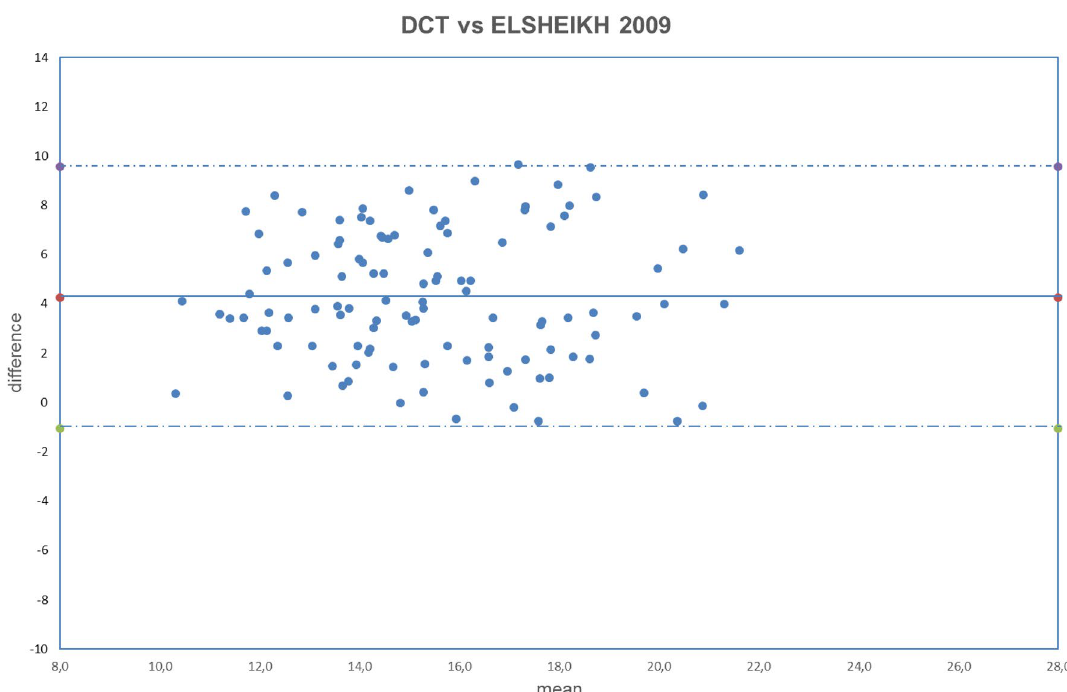
Figure 10. Bland–Altman plot between IOP measured with DCT and GAT corrected with Elsheikh2009 formula. Dashed line: mean difference. Dash-dotted lines: mean difference (4.27 mmHg) ± 2 standard deviation (2.65 mmHg) of the